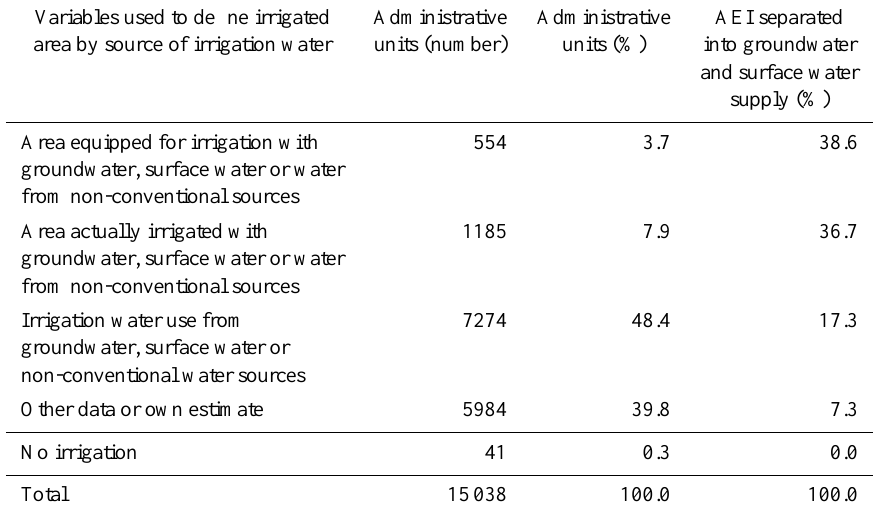
Table 1. Type of census statistics used to define irrigated area by source of irrigation water, number and percentage of administrative units or percentage of global area equipped for irrigation (AEI) for which the different variables were used.